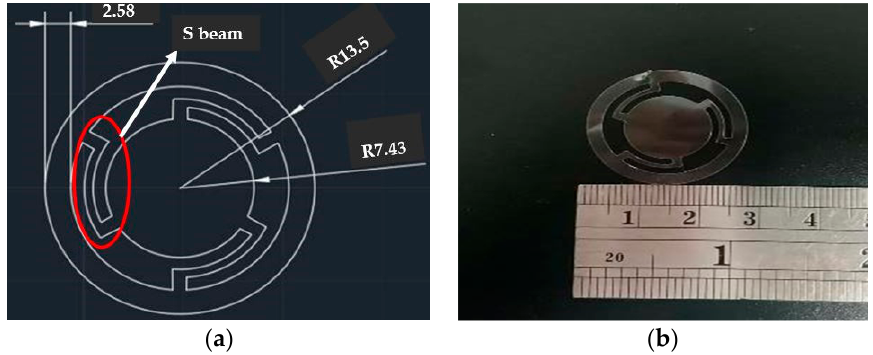
Figure 2. ( a ) Dimension of the check-valve (unit mm); ( b ) PET disc-cap made by a cutting plotter Graphtec CE5000-60. Graphtec